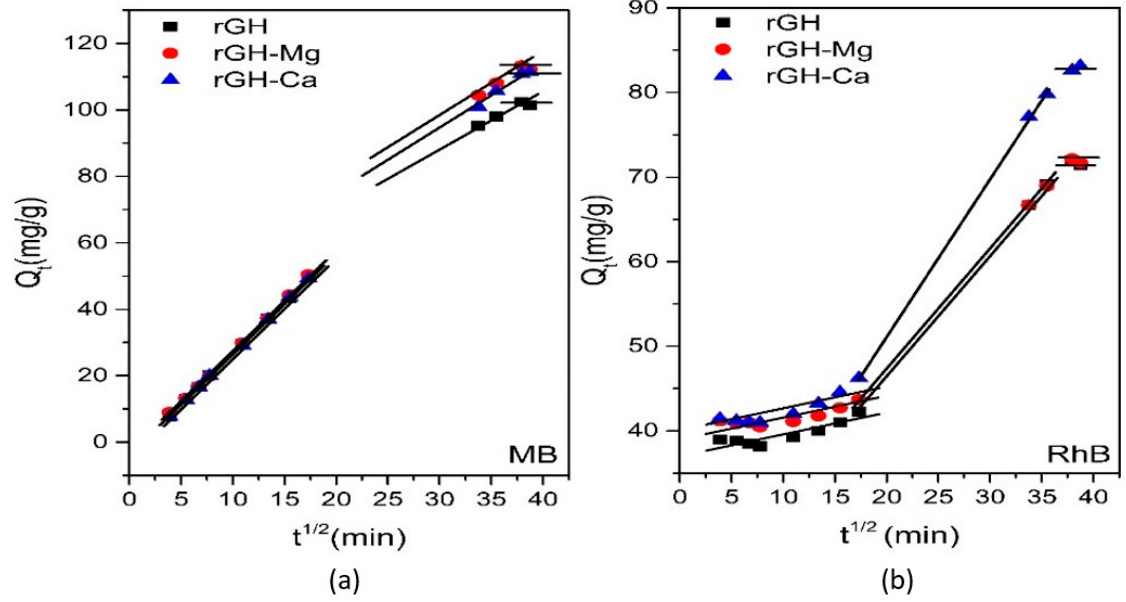
Figure 6. Intraparticle diffusion (IPD) plot of ( a ) MB and ( b ) RhB adsorption onto the hydrogels. From Supplementary Table S1, the negative C value obtained for MB absorption can be attributed to the combined effects of film diffusion and surface reaction control which has been previously reported [77]. For MB adsorption, K 1 > K 2 indicated a faster diffusion process during the initial stage of adsorption. However, as for RhB adsorption, the value of K 1 > K 2 , indicating that IPD process was faster than the first step. Hence, it is considered that surface adsorption involving PSO and IPD are involved simultaneously in the ad- sorption of the dye compounds. 3.3.3. Adsorption Isotherm The study into the adsorption isotherm provided vital insights into the interaction behavior of the adsorbate and adsorbent. It is important to establish the correlation for the equilibrium curve for the optimization of a dye adsorption system. Table 6 summarizes the equilibrium isotherm constant for the adsorption of MB and RhB using the hydrogels. For both the adsorption of MB and RhB, it was found that the experimental data con- formed to the Langmuir isotherm model yielding linear correlation coefficients (R 2 ) closer to unity for rGH, rGH-Mg, and rGH-Ca as compared to Freundlich and Temkin isotherm model. Hence, it can be posited that the adsorption sites on the rGHs were occupied by dye molecules in monolayer form having the same adsorption energy. Further, Langmuir isotherm can be used to access the maximum adsorption capacity ( Q m ) of the hydrogels towards MB and RhB. Interestingly, the maximum adsorption capacity for MB followed the following trend: rGH (282.49 mg/g) > rGH-Ca (224.22 mg/g) > rGH-Mg (243.31 mg/g).